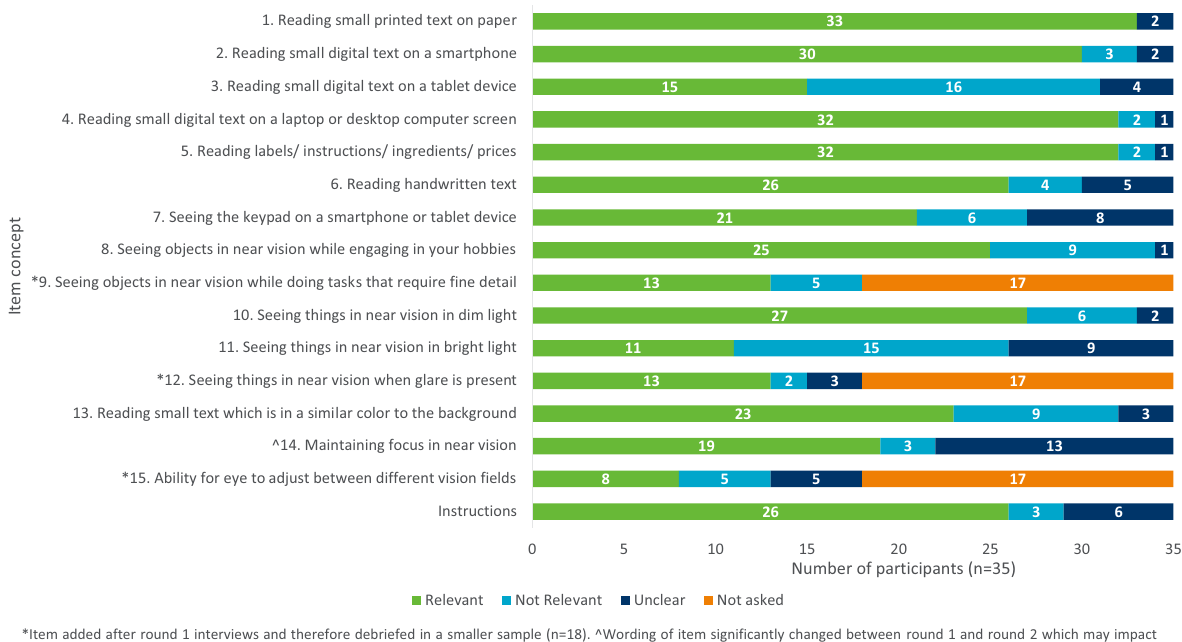
Fig. 3 Summary of overall conceptual relevance (round 1 and round 2